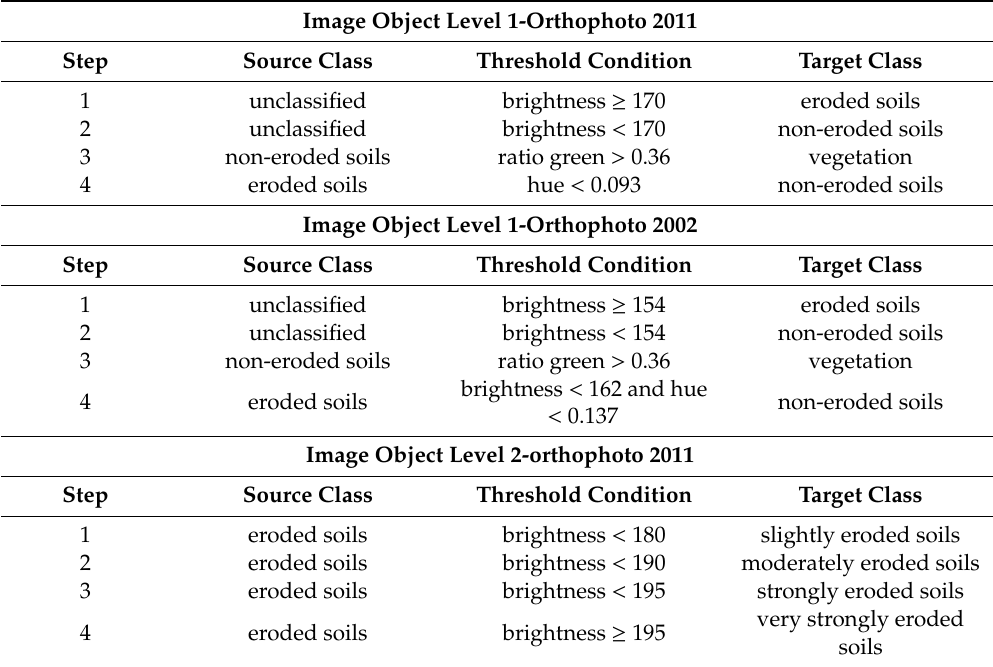
Table 1. The object-based procedure applied to image